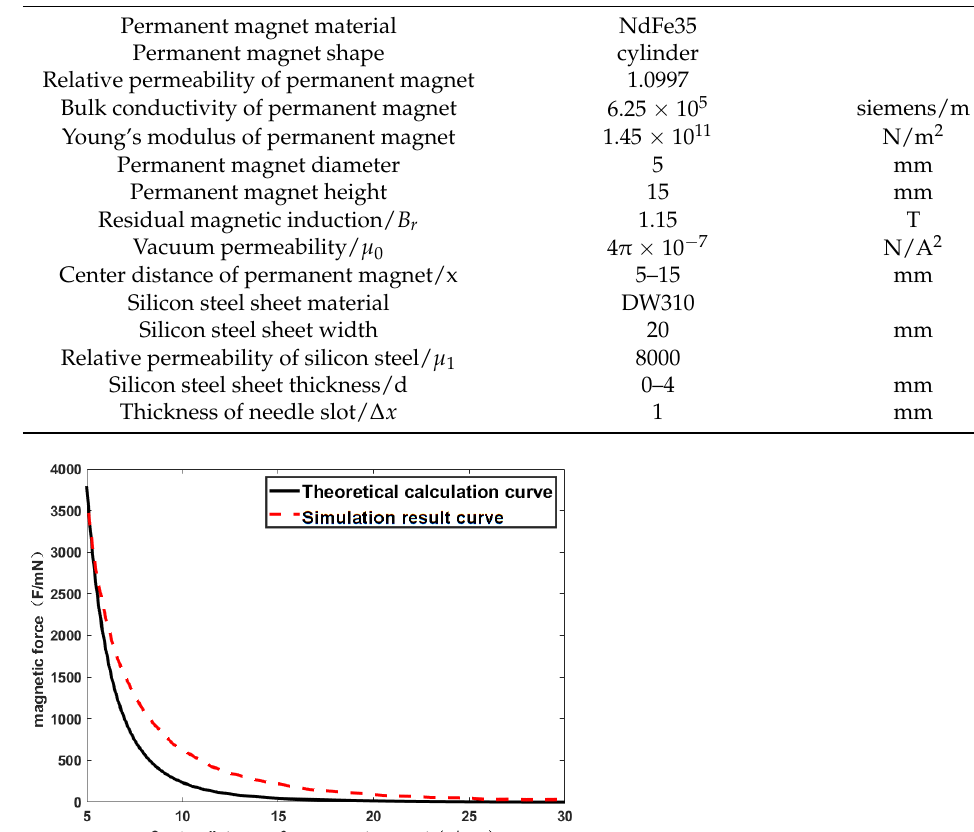
. Figure 4. Simplified model of silicon steel magnetic isolation.